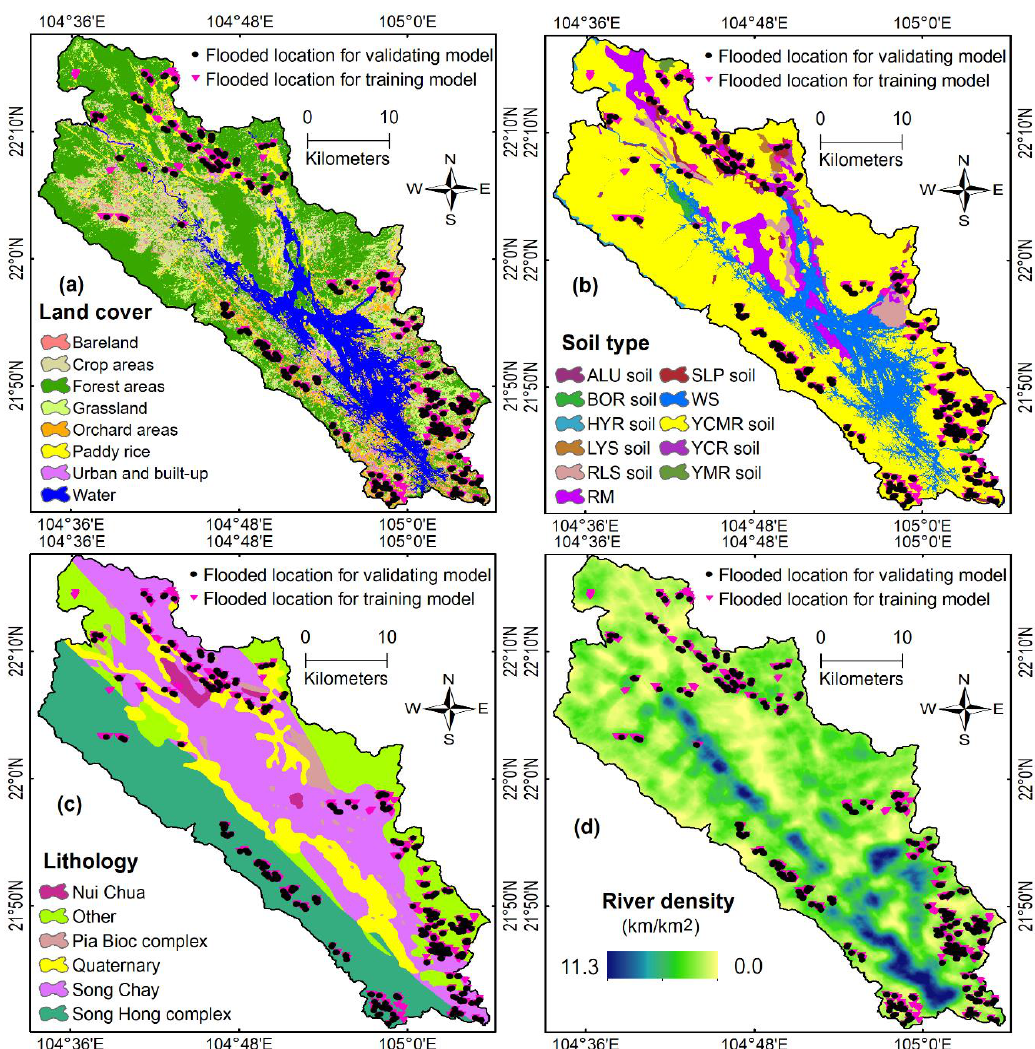
Figure 2. Flash-flooded influencing factors: ( a ) Land cover, ( b ) Soil type, ( c ) Lithology, and ( d ) River density.